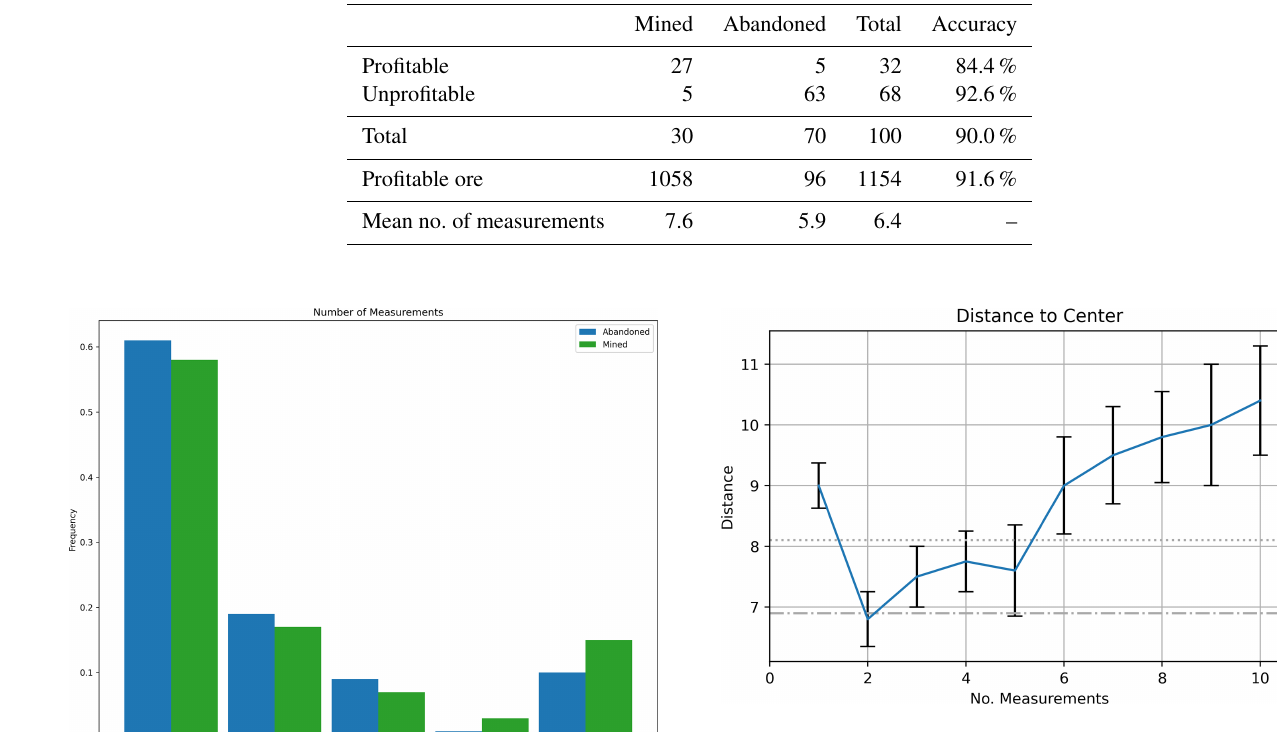
Figure 16. Measurement distance to center, POMCPOW with ac- tion constraints, single body with fixed location. The plot shows the average distance between the measurement location and the miner- alization center for the measurements at each time step. 1 standard error bars are also presented. The dotted line is the maximum ore body radius, and the dash–dotted line is the mean ore body radius. Note that the intelligent agent steps further out because of the im- perfect measuring of the ore body